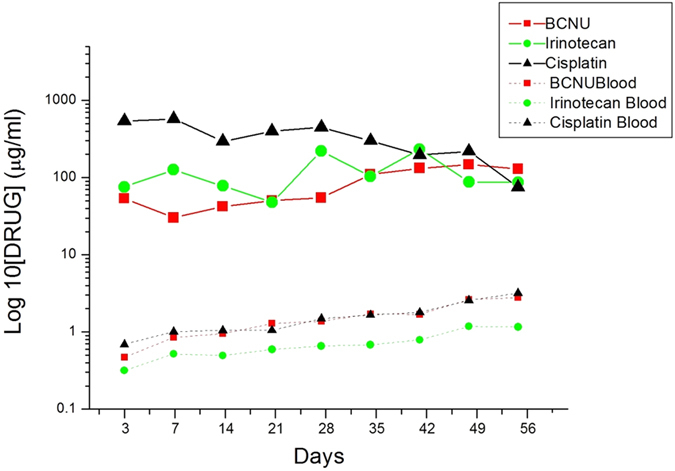
In vivo release curves for the release of BCNU, irinotecan, and cisplatin from the biodegradable nanofibrous membranes.